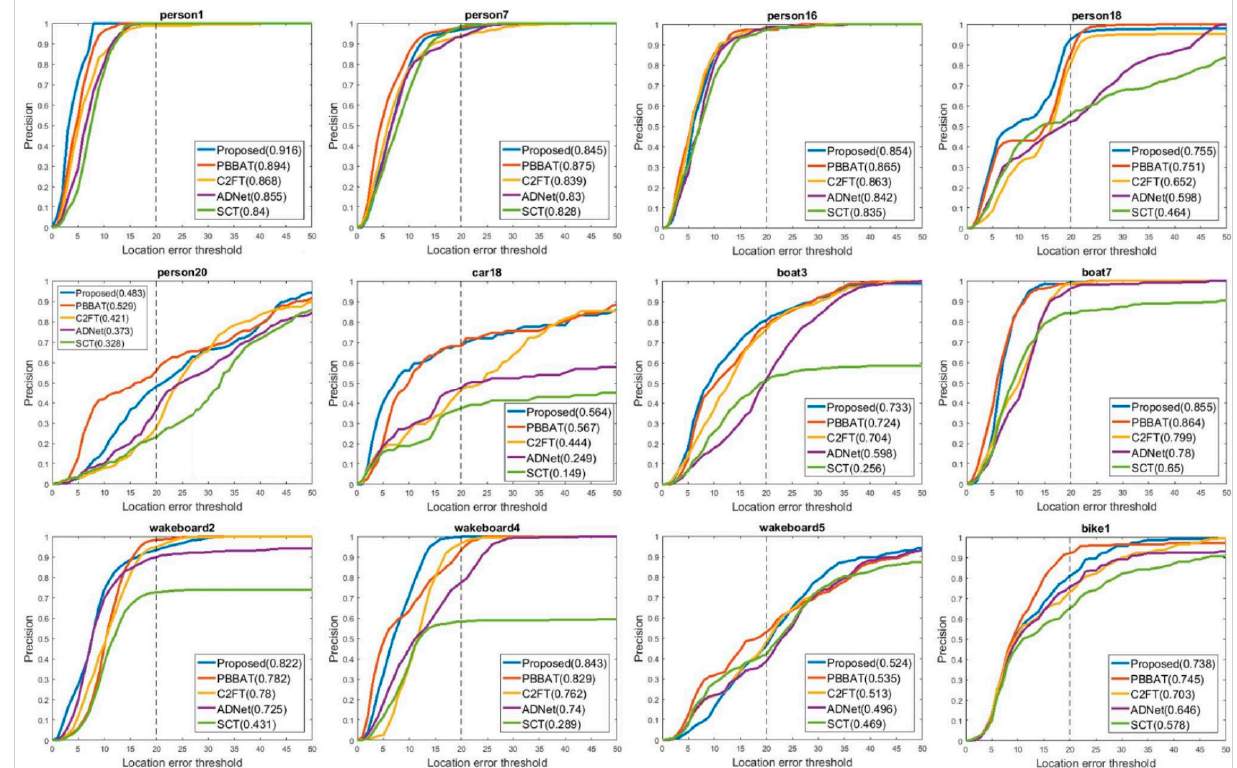
Figure 17. The precision plot of OPE on UAV123